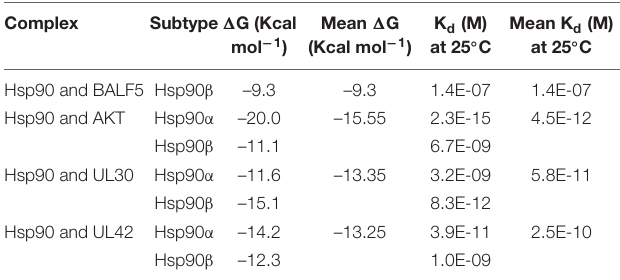
TABLE 2 | Binding affinity ( (cid:49) G) and dissociation constant (K d ) predicted values for the interaction between viral proteins and Hsp90 β . Complex